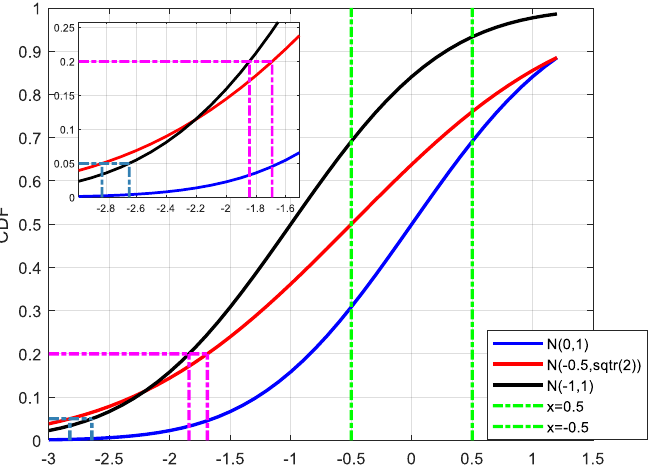
Figure 2. The trade-off between the mean and standard derivation of the Gaussian distribution when the error samples are overbound. The choice of a better overbounding function with higher availability may be different if the integrity risks are settled differently.